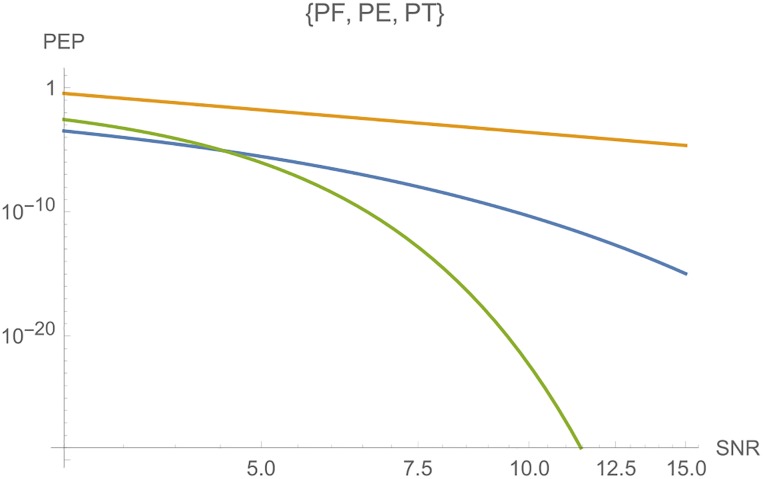
Graphs of PE, PT and PF for nT = nR = l = 2, where the SNR is a function of Es, for c = 10.